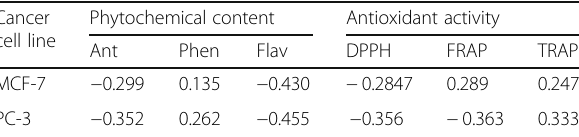
Table 5 Pearson ’ s Correlation Coefficient (r) between the Phytochemicals and the Antioxidant Activity with MCF-7 and PC-3cancer cell lines